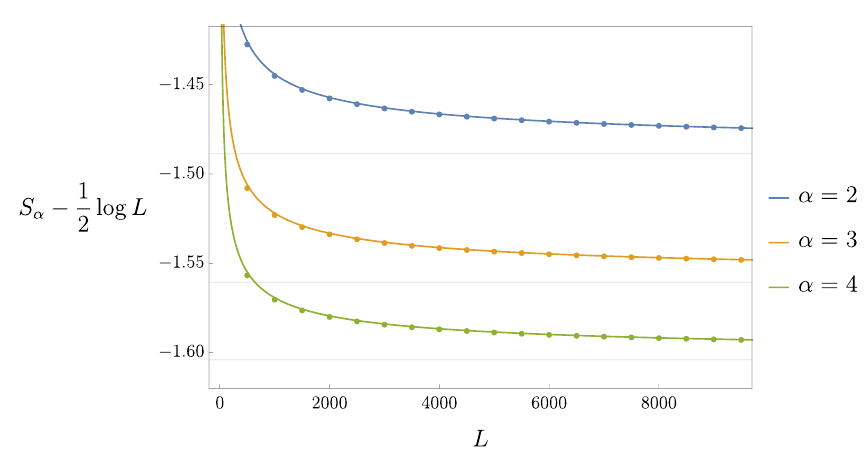
Figure 3: The Rényi entropies S α , with α = 2,3,4, of the time averaged state in the time window [ 0,0.4 J − 1 ] after a quench of the magnetic field h = ∞ → 1.5 in the transverse field Ising chain (82). The dots correspond to numerical evaluations of (11). The curves are the asymptotic predictions plus the leading correction computed in Appendix C. The horizontal lines show the limit L → ∞ (which are the predictions without the leading